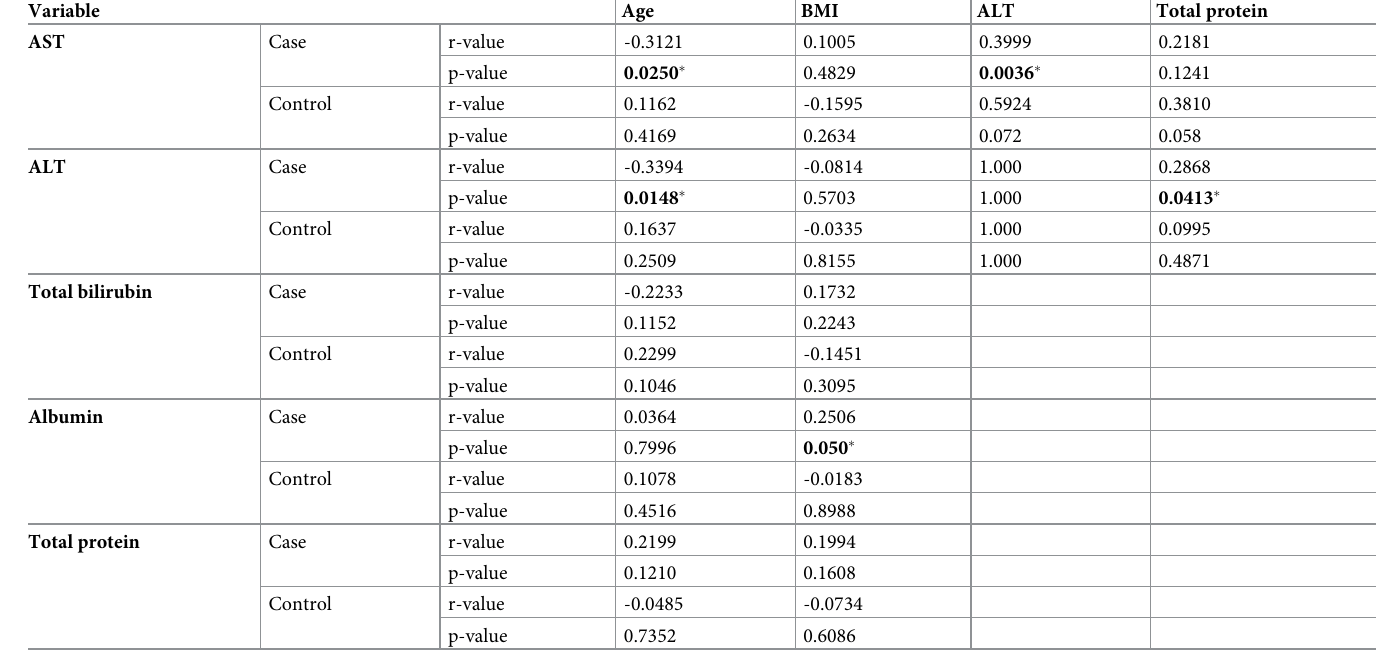
(r-value = pearson’s correlation coefficient, � = statistically significant at P <